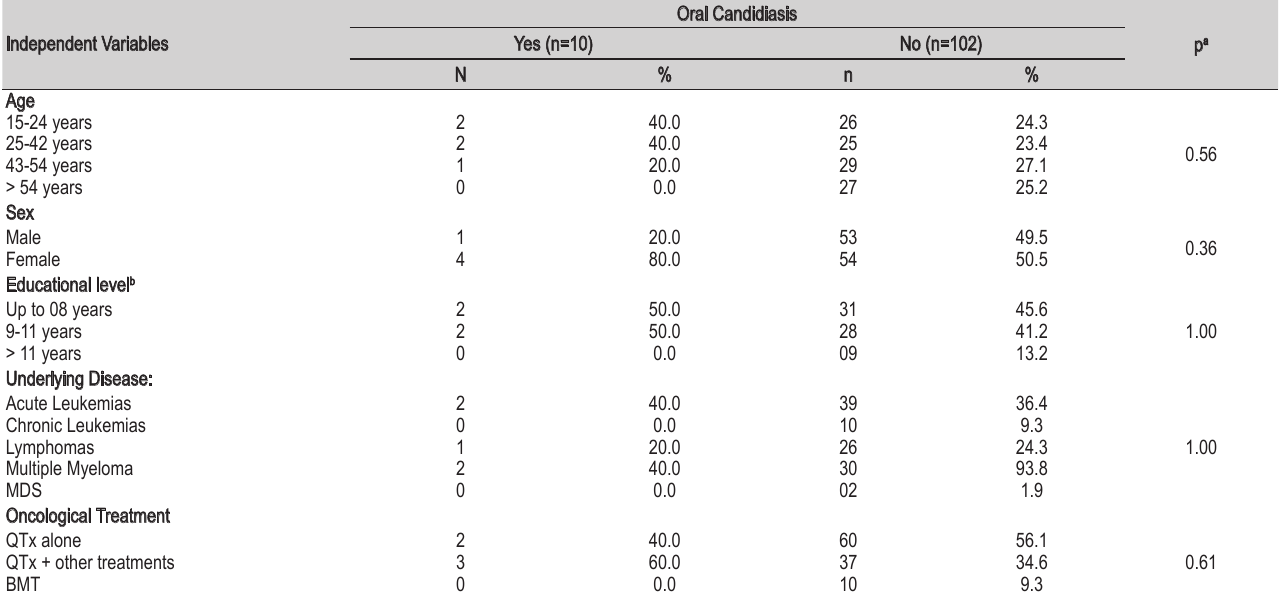
Table 3 - Association between herpes simplex and age, sex, educational level, underlying disease and oncological treatment instituted in onco-hematologic individuals of HUPES/UFBA, Salvador, Brazil,